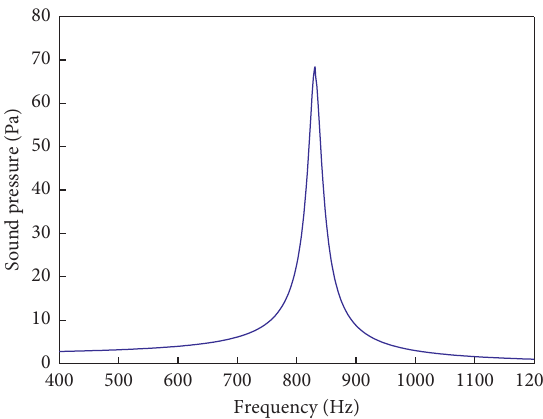
Figure 7: Frequency response of Helmholtz